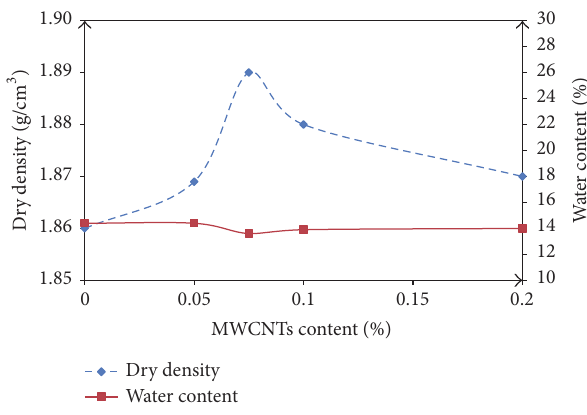
Figure 11: Effect of MWCNTs on the OMC and MDD.